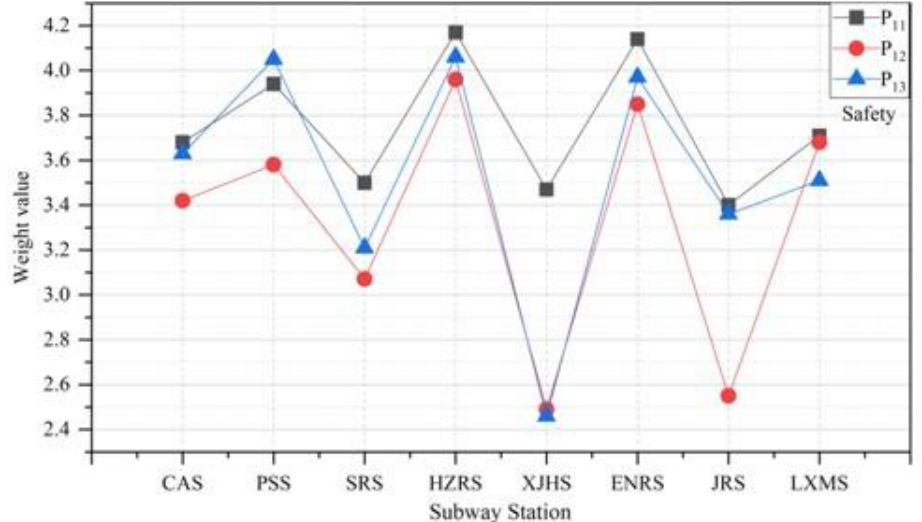
Figure 8. The evaluation results of the environmental safety evaluation index of the transfer spaces of sample stations.